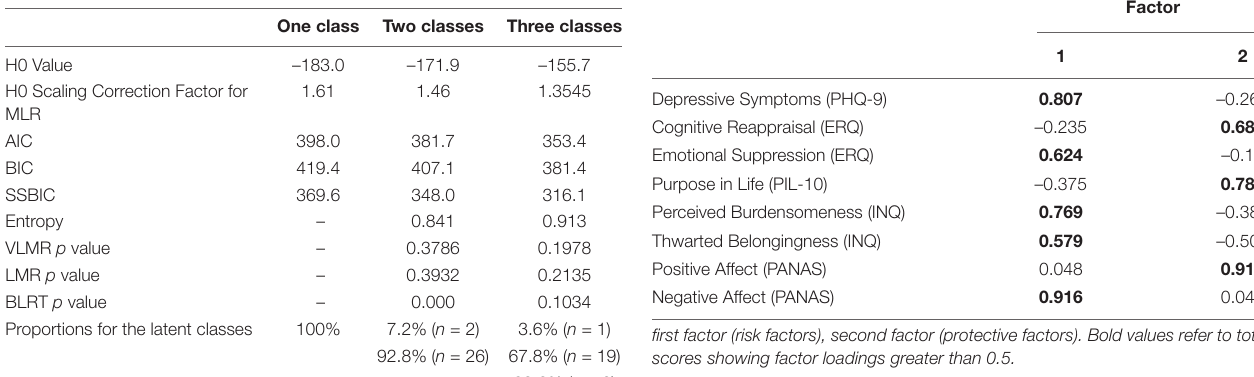
TABLE 2 | Fit indices for one- to three-class growth mixture models (unconditional).